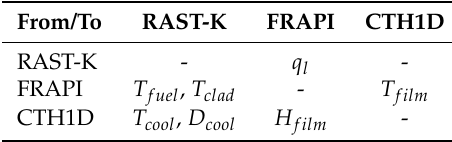
Table 1. Exchange of feedback